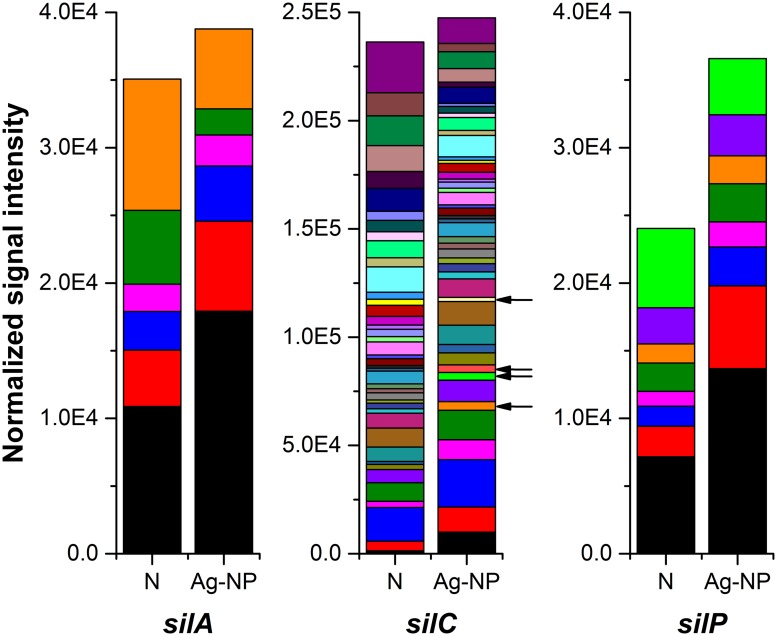
Effects of Ag-NP treatment on genes associated with silver resistance. N indicates samples with no treatment and Ag-NP indicates samples with Ag-NP treatment. Colors are coded according to the lineage; genes from gene variants present only in Ag-NP treated samples are indicated with black arrows.